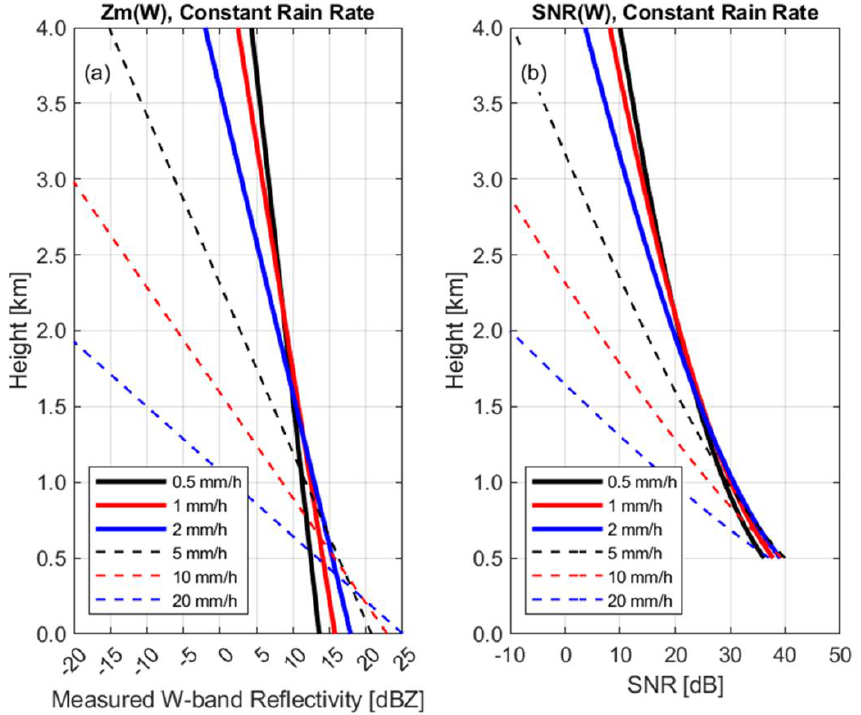
Figure 7. Estimated W-band measured reflectivity 𝑍 𝑚𝑊 and 𝑆𝑁𝑅 as a function of range for rain shafts with constant rain rates of 0.5, 1, 2, 5, 10, and 20 mm h −1 . ( a ) Simulated measured reflectivity factor 𝑍 𝑚𝑊 [dBZ] and ( b ) signal-to-noise ratio 𝑆𝑁𝑅 [dB].